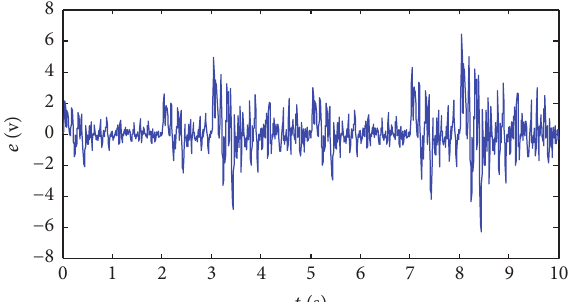
Figure 7: Control performance with fast model change.